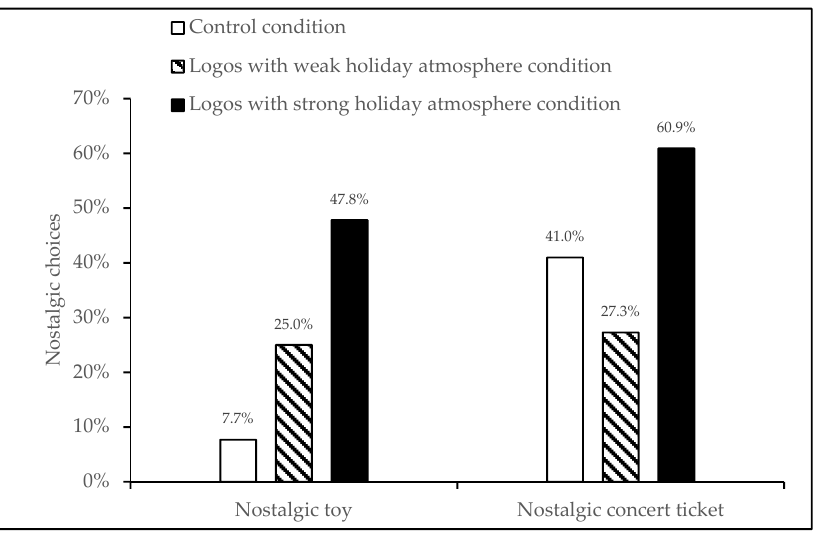
Figure 2. Study 1: the effects of logo’s holiday atmosphere on choices of nostalgic products.